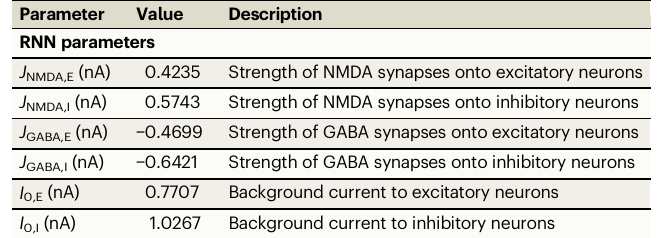
Table 3 | Four-variable mean- fi eld model